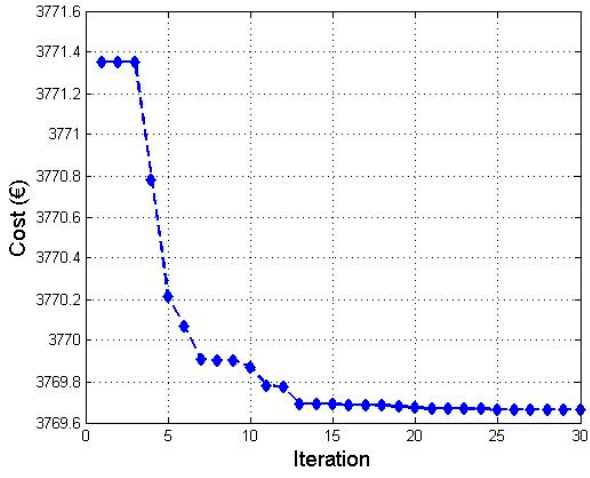
Figure 11. Convergence of gBest .